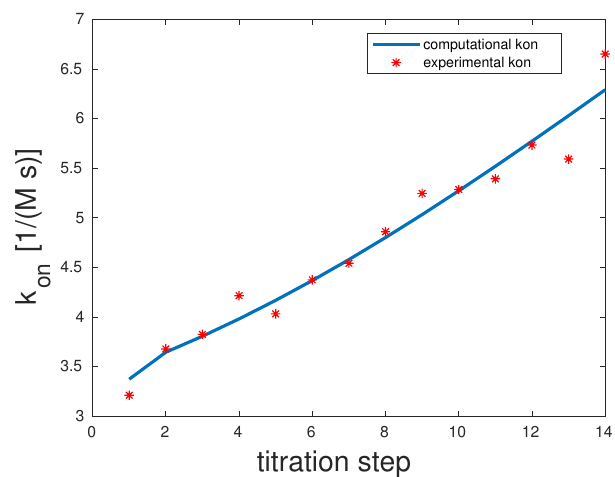
Figure 2. Comparison of the computed and experimental [14] k on rates for bivalent Man(1,5)-5; see the Supplementary Information (SI) for additional information on experimental data. The theoretical k on rates were 100 and one, and those of k off were one and one.